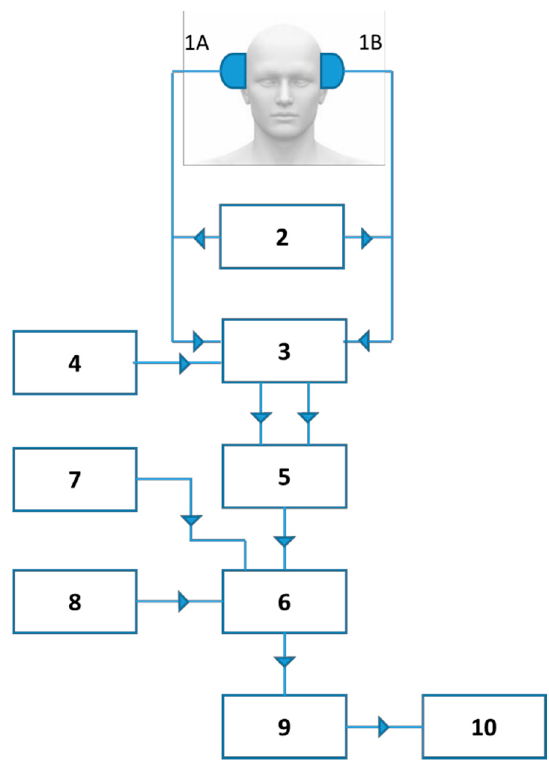
Figure 2. Technological arrangement concerning the equipment used (according to reference 27): 1A, 1B, 2-MHz emitting–receiving probes; 2, voltage transmitter; 3, Amplifier; 4, Time gain compensator (TGC); 5, Binary conversion system (frequency of 18.8 MHz); 6, Ultrafast computing unit; 7, Delay device; 8, Digital rejection filtering system; 9, Digital computer; 10, video screen (Oscilloscope).